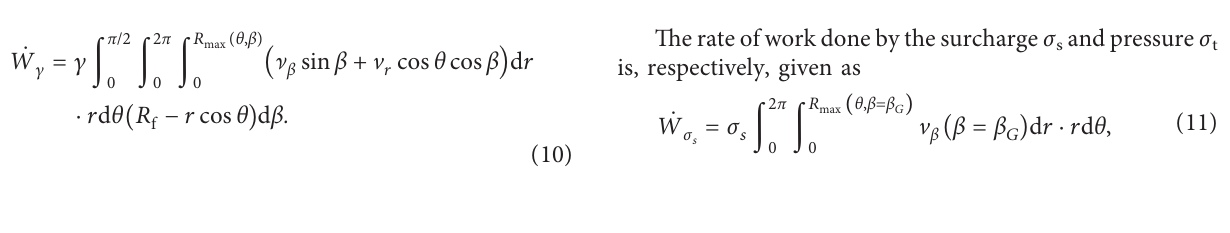
Figure 5: Influence of the parameter L 1 / D on the stability number N for